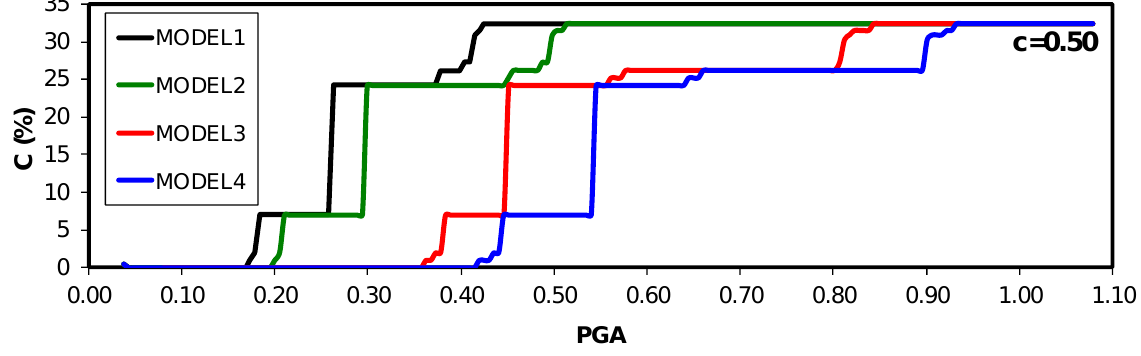
Figure 7. Indirect losses due to connectivity losses (C). Scenario 3: c=0.50.